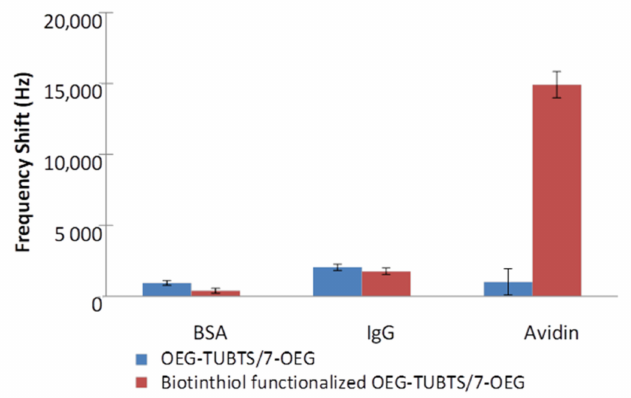
Figure 9. EMPAS frequency shifts measured with OEG–TUBTS/7–OEG and biotinylated OEG– TUBTS/7–OEG SAMs, using 0.1 mg mL − 1 BSA, IgG, and avidin solutions in PBS buffer solution.